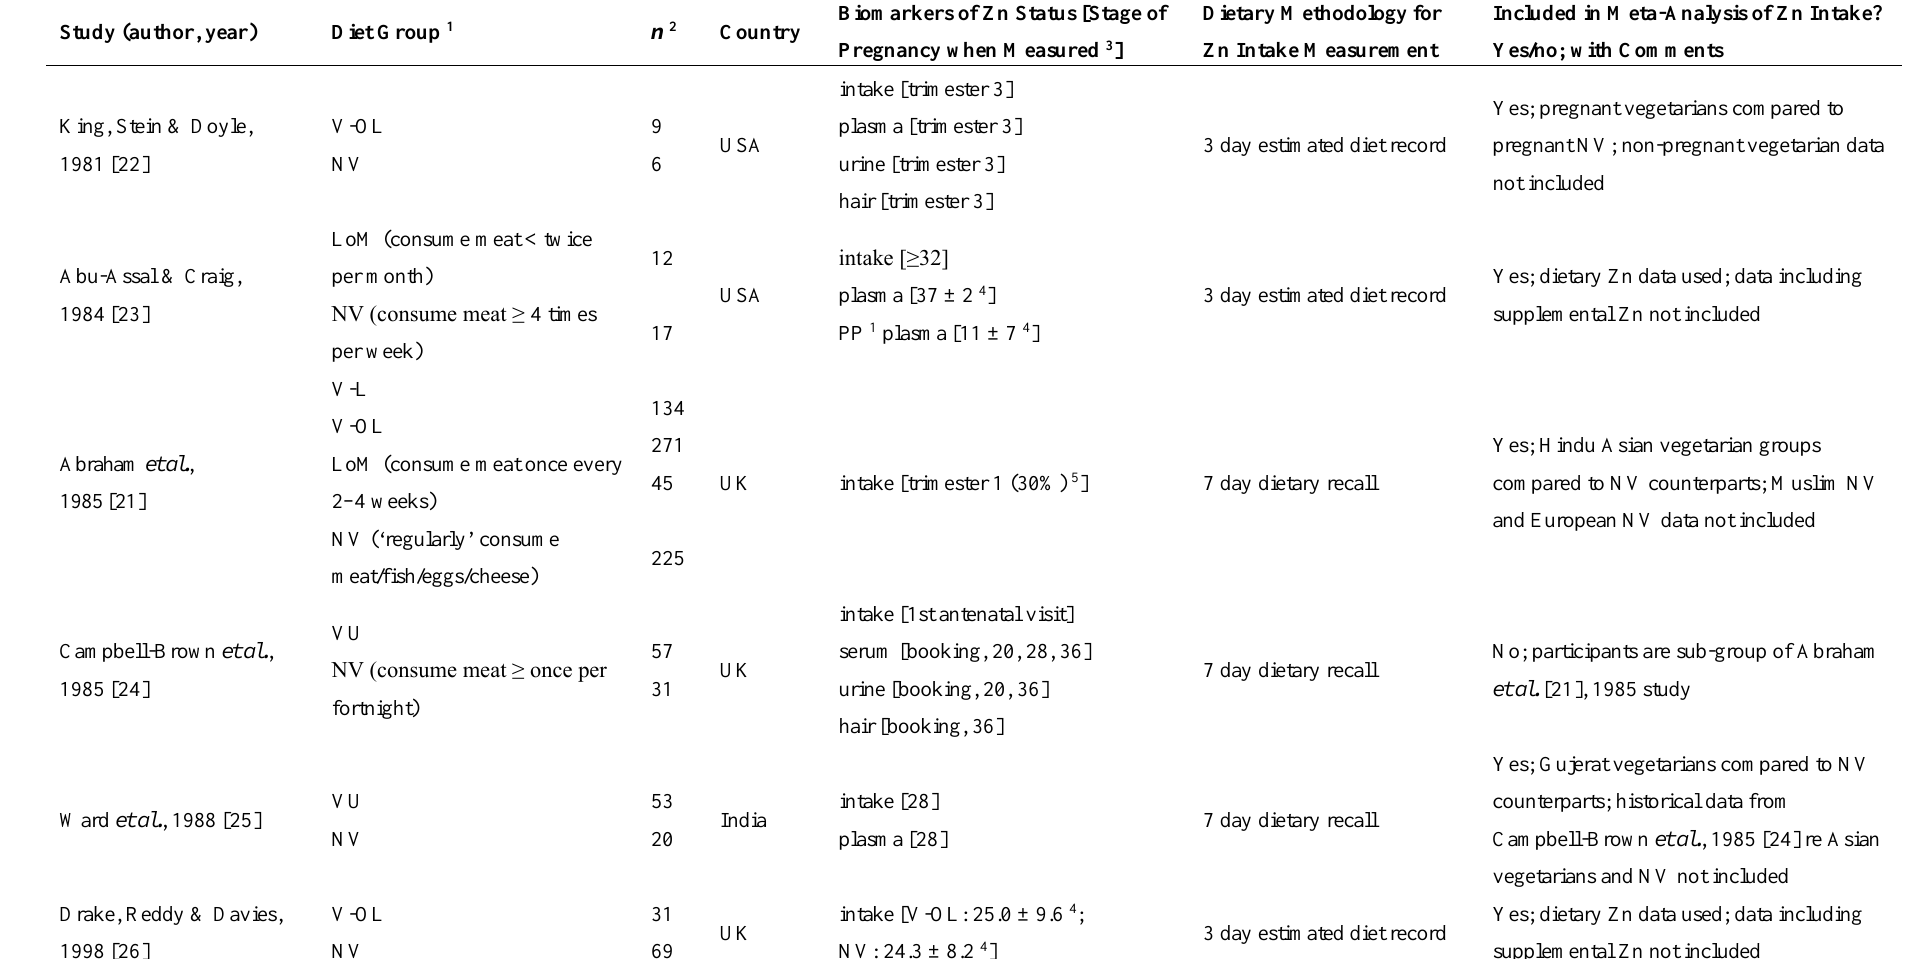
Table 2. Description of included